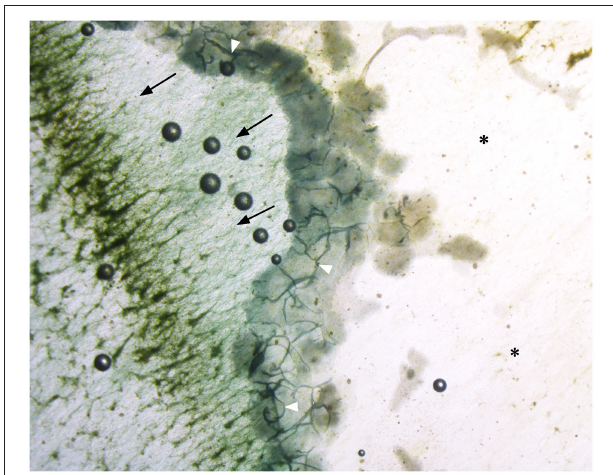
FIGURE 1 | T. adhaerens aggregated on the aquarium wall biofilm. Contact points between Placozoa are visible and dark (white arrowheads). Black arrows indicate the Placozoa march direction. The surface after the passage of the T. adhaerens front appears depleted of algae (asterisks, right side). Magnification: 10X.